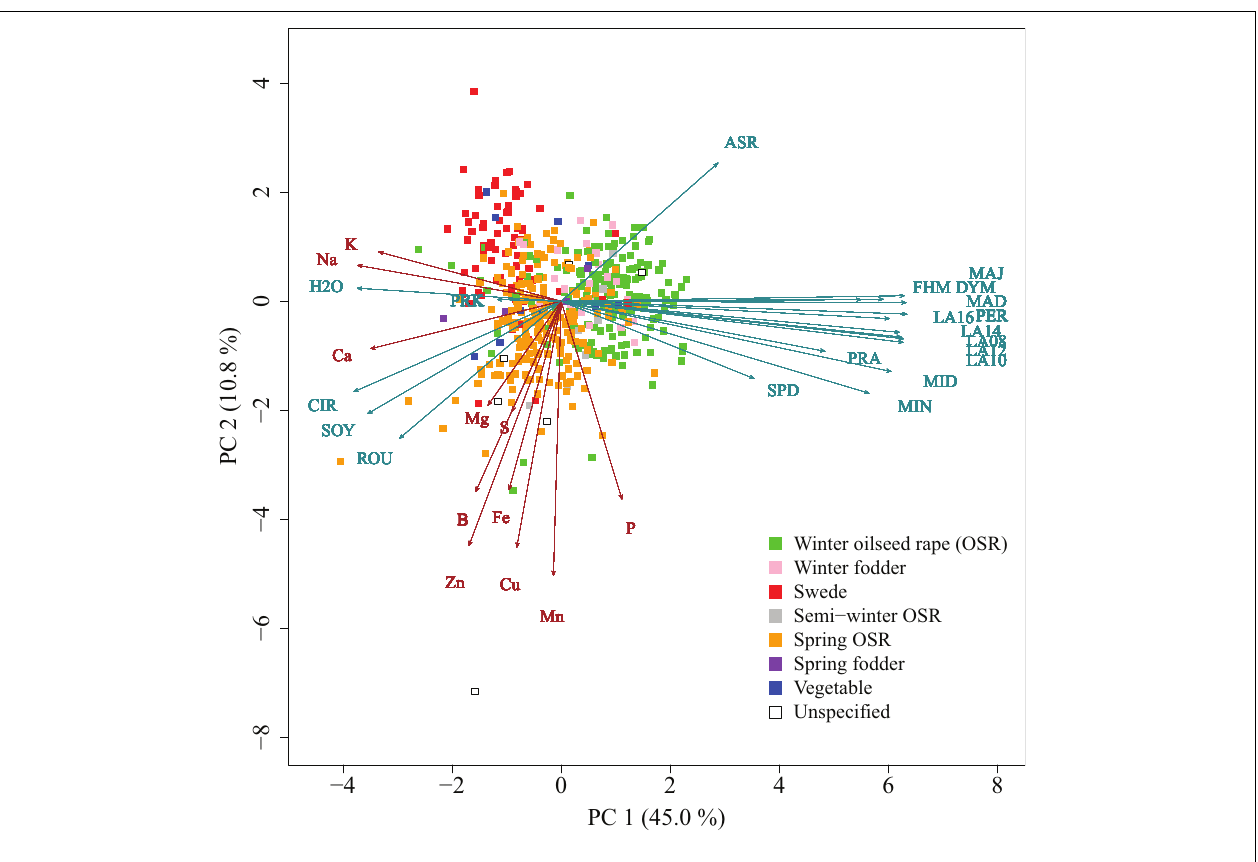
FIGURE 2 | Principal component analysis of 509 B. napus inbreds (points), seedling development traits (turquoise arrows), and mineral concentrations (brown arrows). Germplasm types are represented by